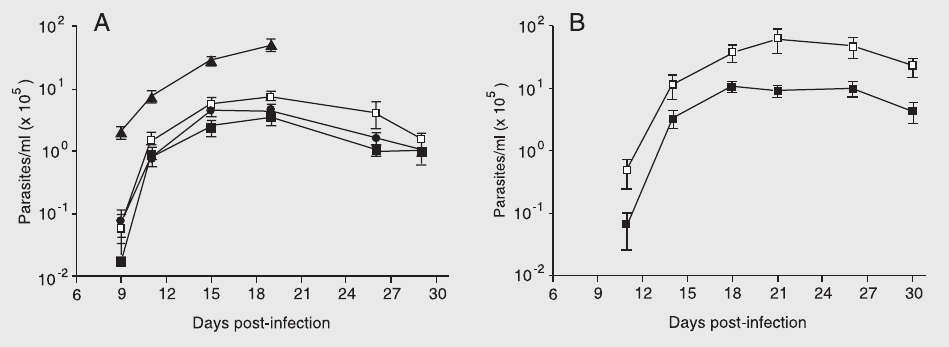
Figure 1. Parasitemia of Trypa- nosoma cruzi -infected BALB/c (A) and C3H/c mice (B). Mice were infected with sublethal doses of Tulahuen-2 trypomas- tigotes and treated with mercap- toethylguanidine (filled squares), guanido-ethyl disulfide (circles) or N G -nitro-L-arginine methyl ester (triangles), or not treated (open squares). Data are re- ported as means ± SEM for 5 to 8 mice per